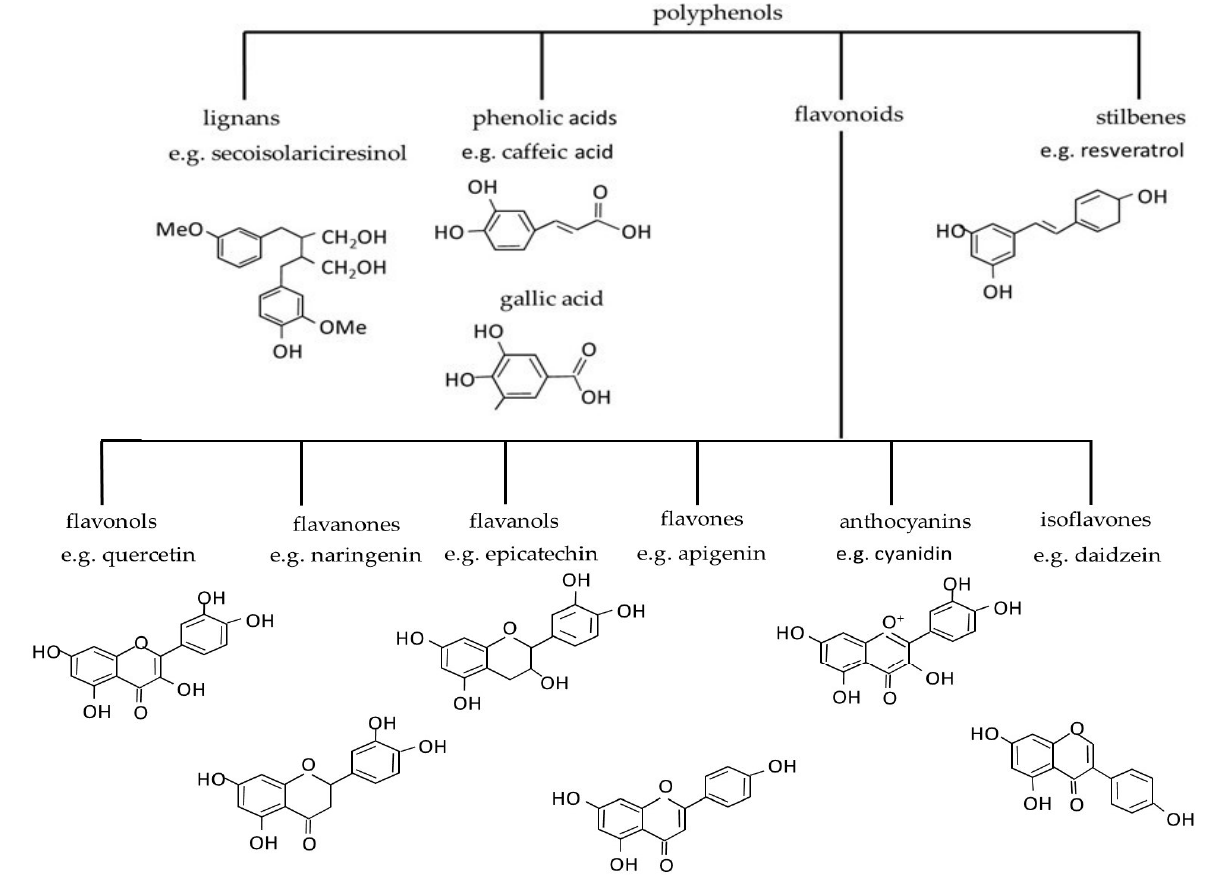
Figure 1. Classification and chemical structure of major classes of dietary polyphenols. Adapted from [47,48] .